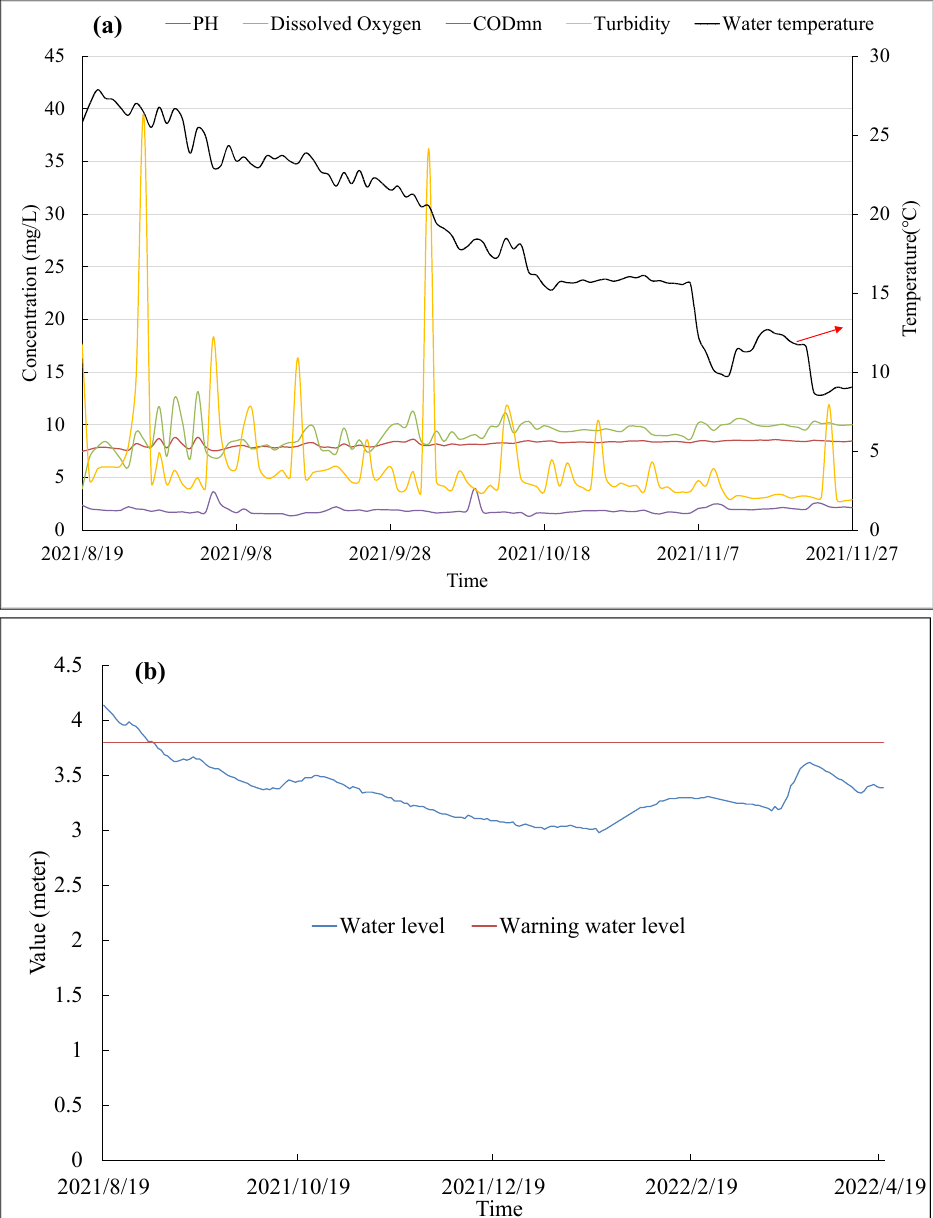
Figure 7. Part of the hydrological monitoring data at Taihu station ( a ) and water quality of North Moat station ( b ).